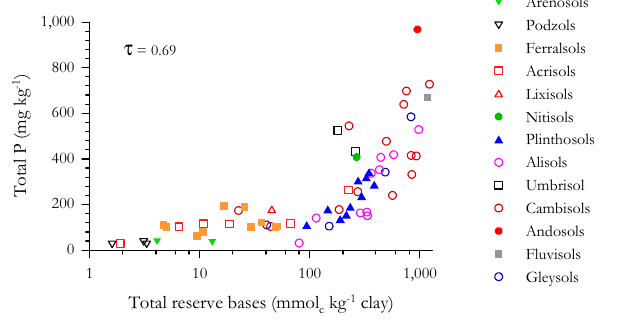
Fig. 8. Relationship between total phosphorus concentration and the chemical weathering index Total Reserve Bases ( P RB ) . Note that only X-axis is in logarithmic scale. Values of Kendall’s τ rank correlation coefficient are also shown.